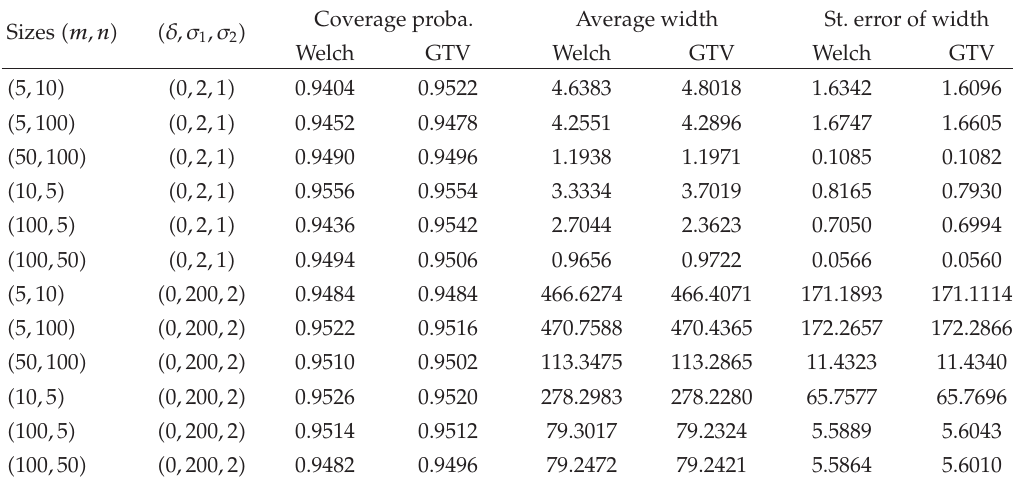
Table 5: Coverage probability for δ (cid:2) normal case with unequal sample sizes (cid:3) .